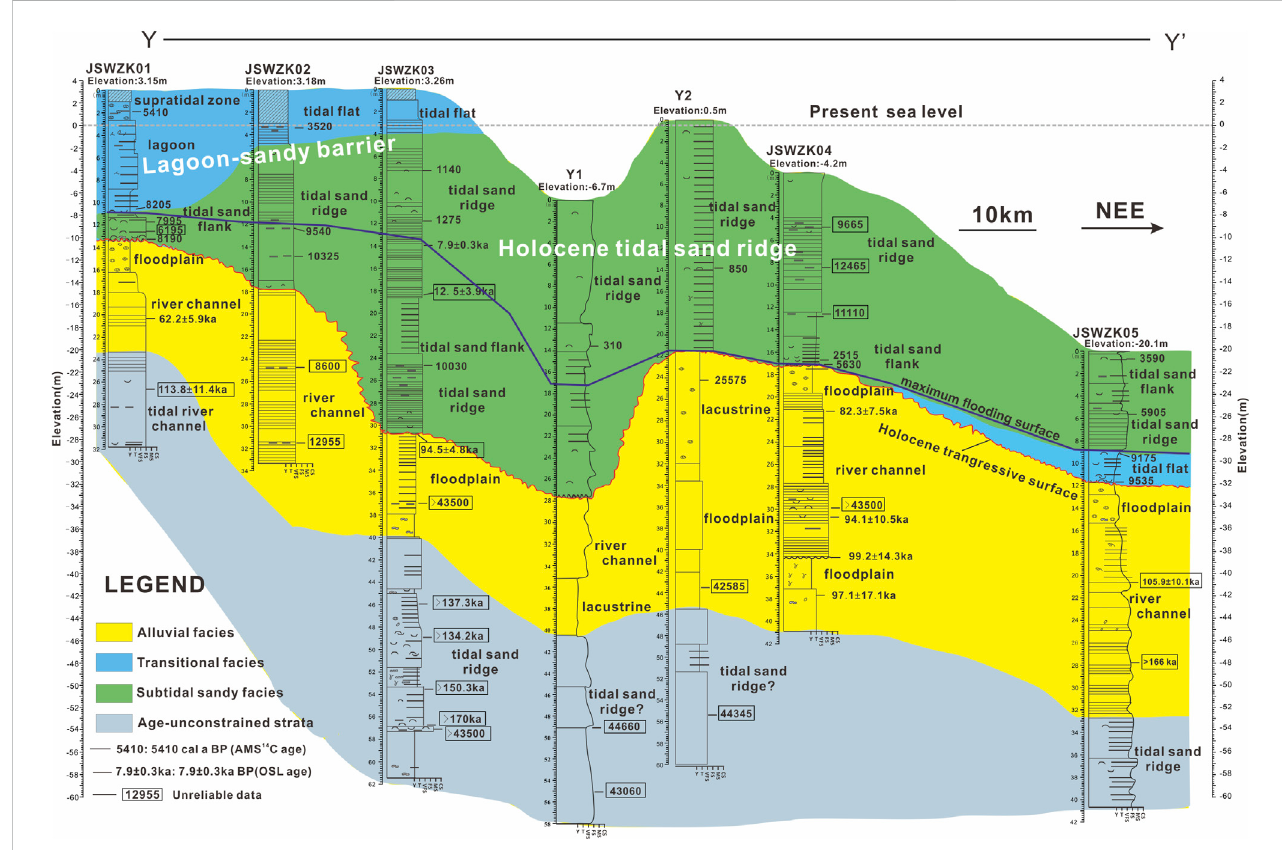
FIGURE 9 Facies architecture along coastal transect Y-Y ′ . Cores Y1 and Y2 are modi fi ed from Wang et al. (2015) and Yin et al. (2016), respectively.